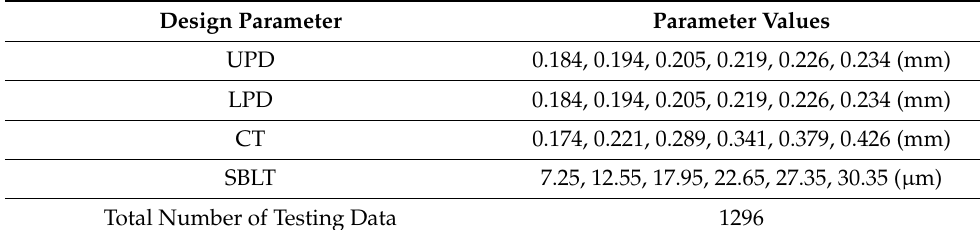
Table 11. Design parameters for 1296 testing data.